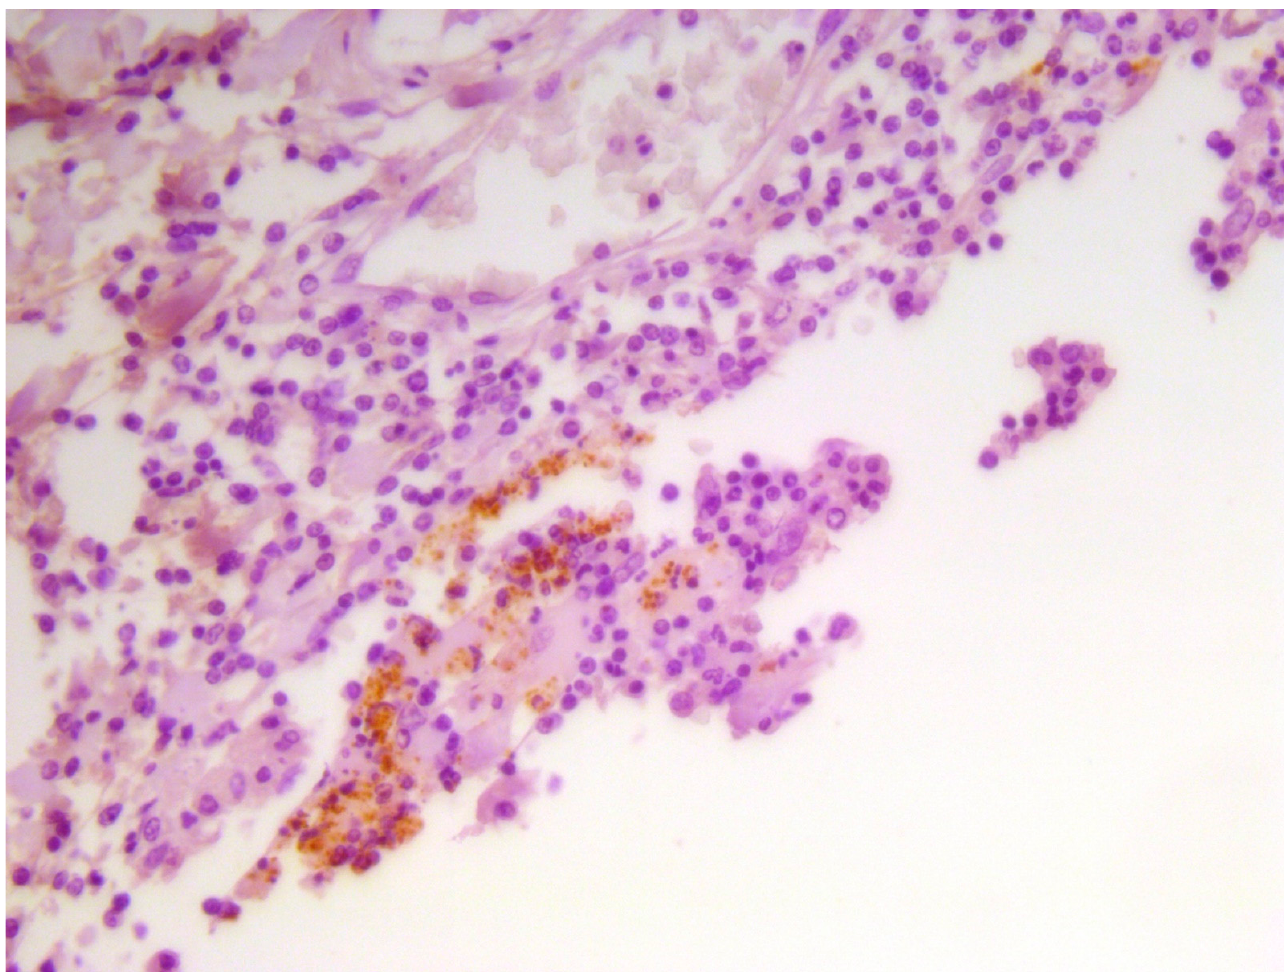
Figure 5. B. ceti -infected, neurobrucellosis-affected striped dolphin ( S. coeruleoalba ) specimen. Cervical spinal cord. Evidence of Brucella spp. antigen in the cytoplasm of macrophages/histiocytes forming the inflammatory infiltrate is shown in this picture. Immunohistochemistry (IHC) against Brucella spp. with an anti- B. melitensis MAb (produced at IZSAM “G. Caporale”, Teramo, Italy), Mayer’s hematoxylin counterstain.